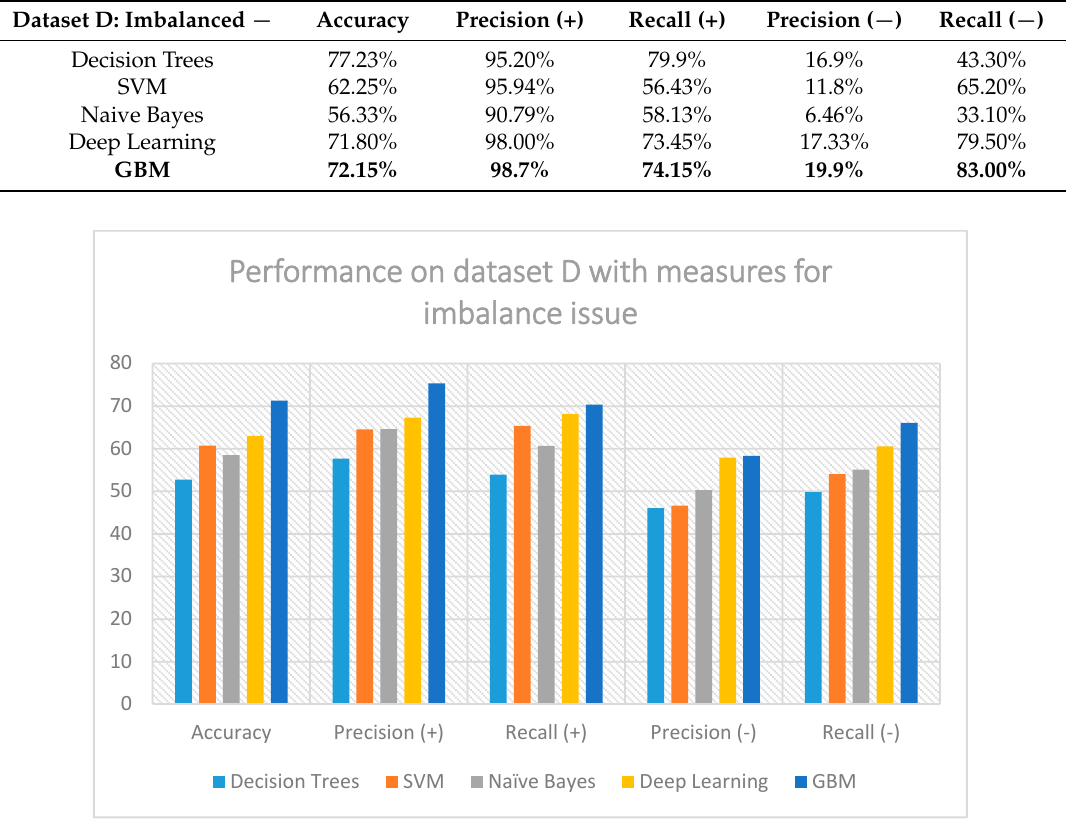
Table 9. Performance of GBM against other benchmarking methods for Dataset D negative imbalanced without any measures for the class imbalance problem.